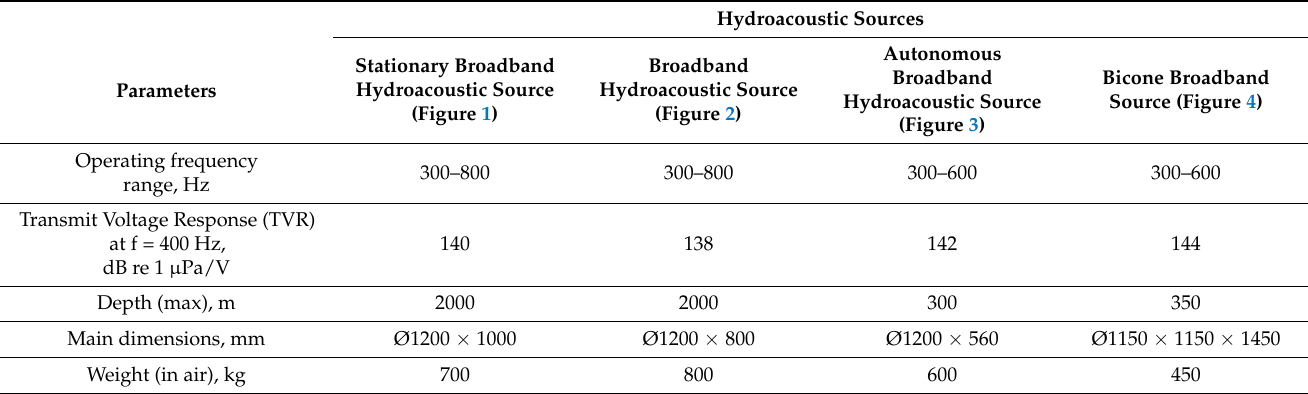
Table 1. Hydroacoustic sources